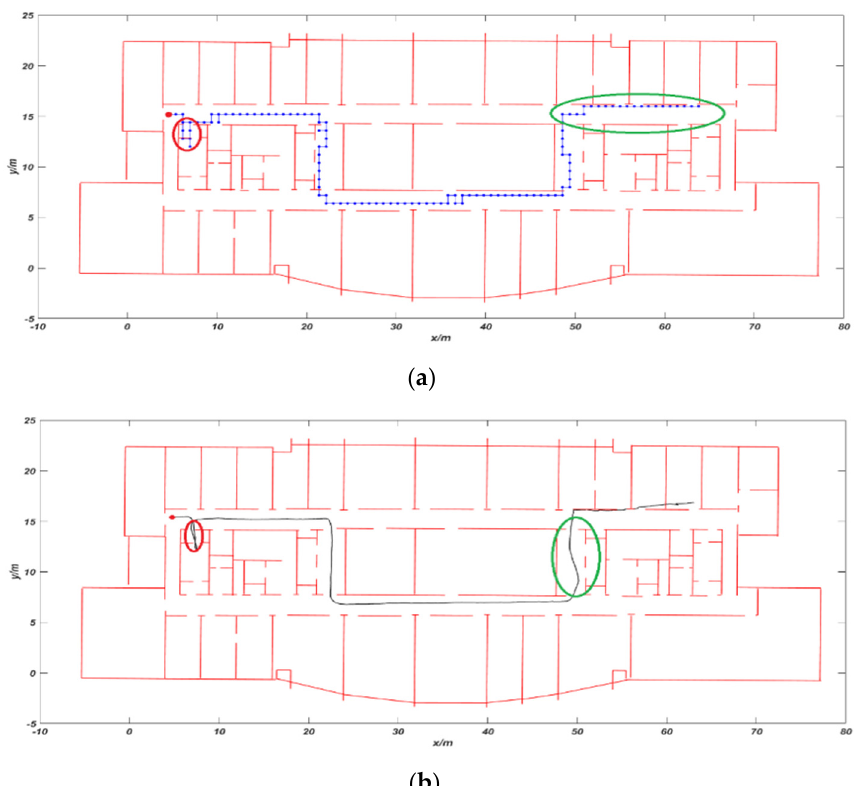
Figure 8. Comparison of trajectory: ( a ) VIO trajectory and ( b ) trajectory using CRF algorithm.